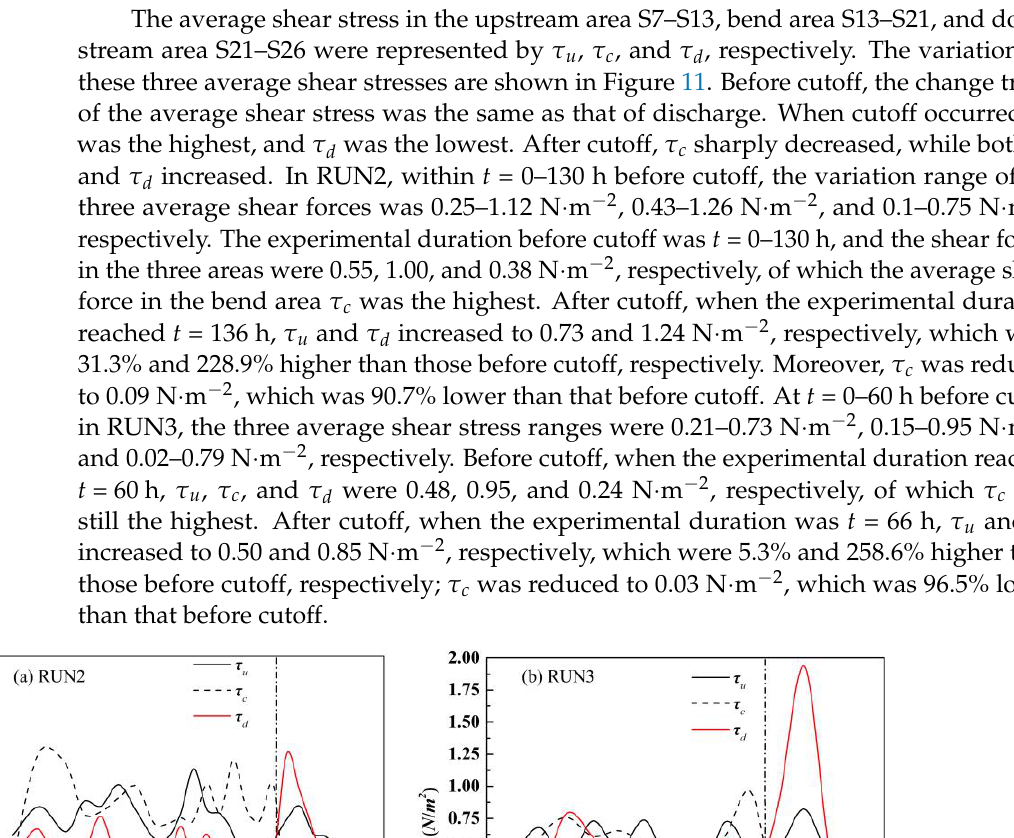
Figure 10. Variations in the water surface gradient during ( a ) RUN2 and ( b ) RUN3. S u and S d showed similar trends, while S c had the opposite trend. After cutoff, S c sharply dropped, while both S u and S d increased.